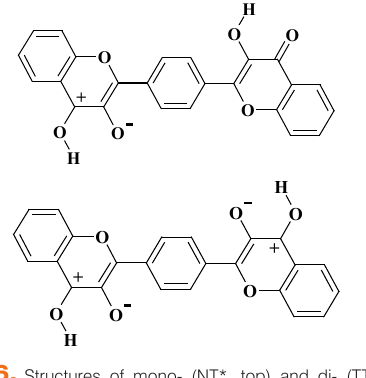
Figure 6. Structures of mono- (NT*, top) and di- (TT*, bottom) phototautomers of bis-flavonol.